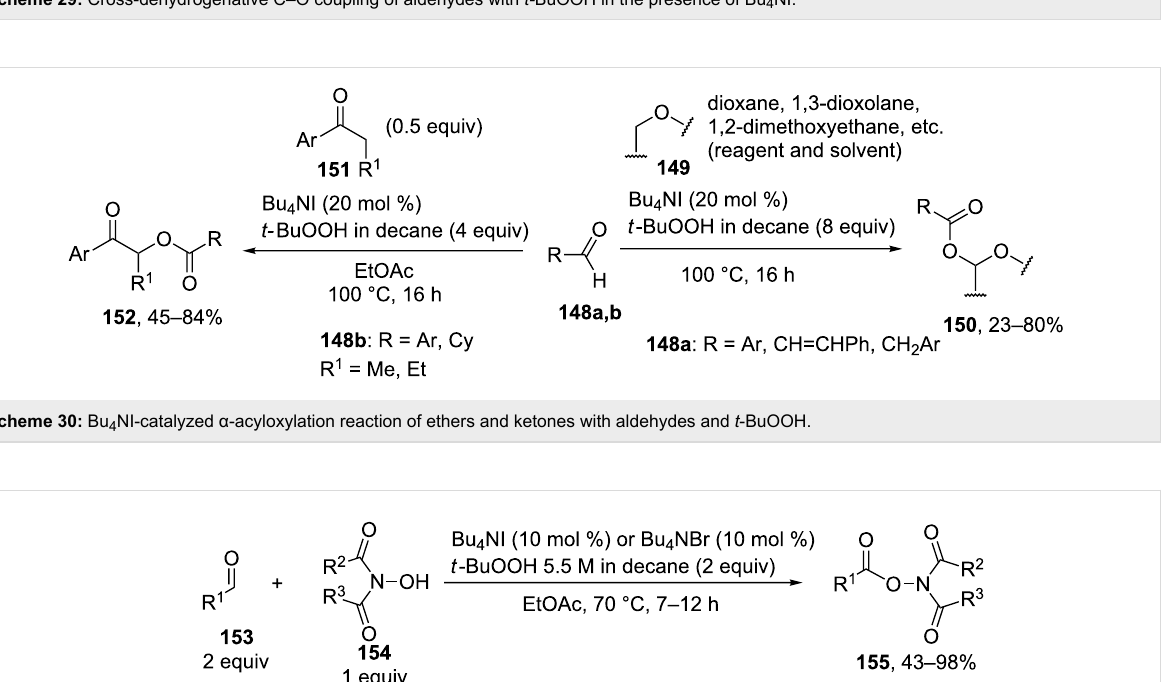
Scheme 29: Cross-dehydrogenative C–O coupling of aldehydes with t- BuOOH in the presence of Bu 4 NI.